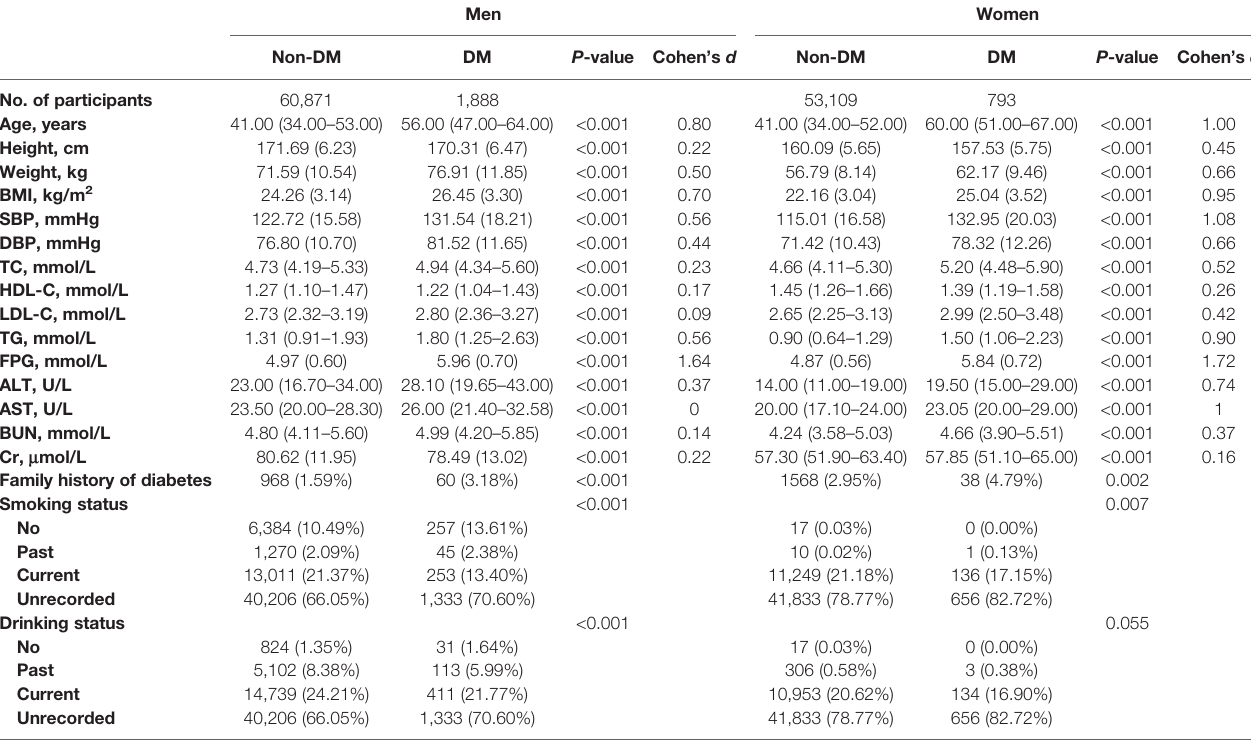
TABLE 2 | Characteristics of the study participants with and without DM. Men Women Non-DM DM P -value Cohen ’ s d Non-DM